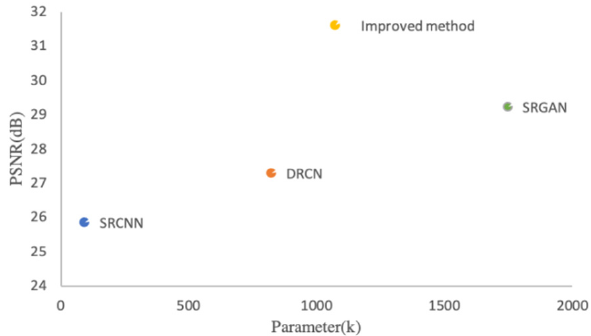
Figure 8. Comparison of network parameters and PSNR. Table 4. PSNR and SSIM comparison on different data sets.